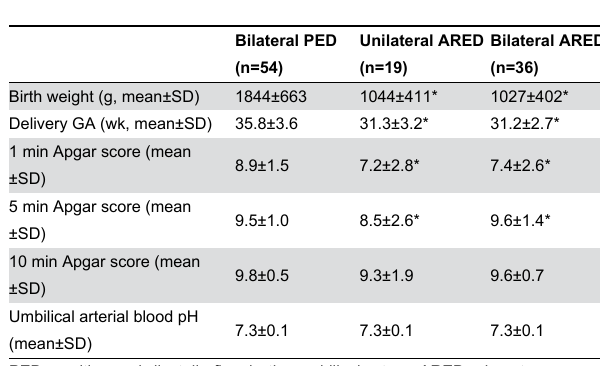
Table 5. Perinatal outcomes depending on the degree of placental compromise.